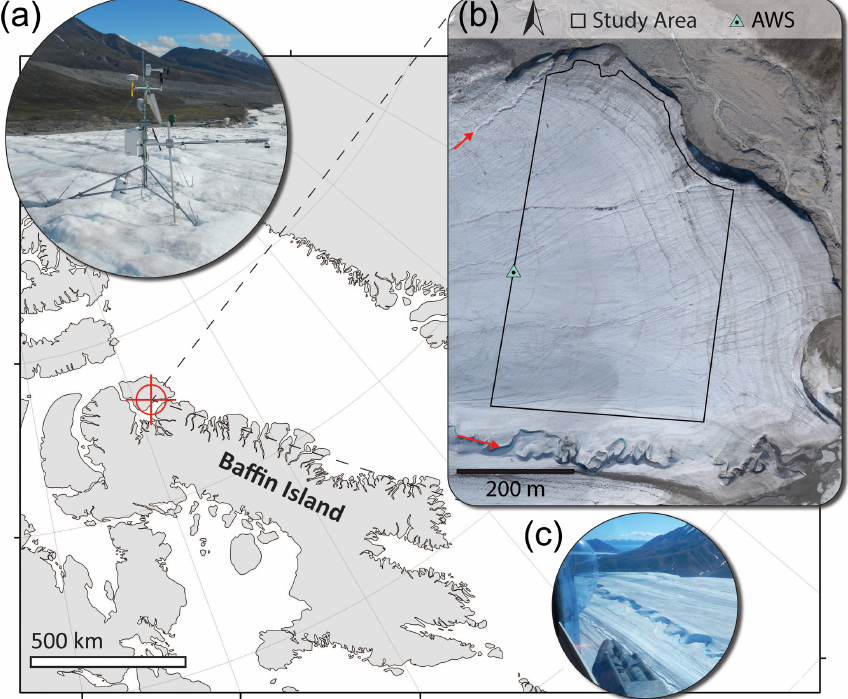
Figure 1. Location of Fountain Glacier on Bylot Island, Nunavut, in the Canadian Arctic. (a) The automatic weather station (AWS) installed on a tripod, measuring incoming and outgoing shortwave radiation and temperature. An SR50 measuring surface position was installed on a separate pole drilled into the glacier (foreground; photo credit: E. A. Bash). (b) A 2011 orthomosaic of the lower ablation zone of Fountain Glacier (Whitehead et al., 2013). The boundary of the study area is shown, which extends to the 2016 glacier boundary on the north side. The AWS location is also indicated (green triangle). Two canyons formed by stream incision are indicated by red arrows. (c) An aerial view of the largest incised canyon on Fountain Glacier. The photo is taken facing east, and the steep north-facing canyon walls can be seen in contrast to the more gently sloping south-facing walls (photo credit: B. J.